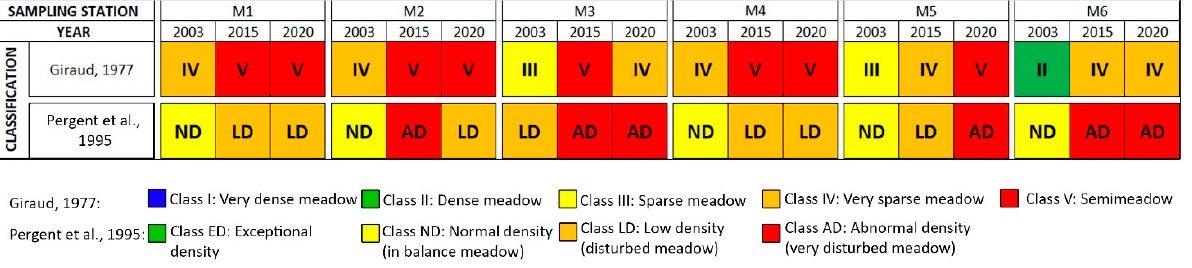
Figure 3. Classification of the meadow according to Giraud [46] and Pergent et al.